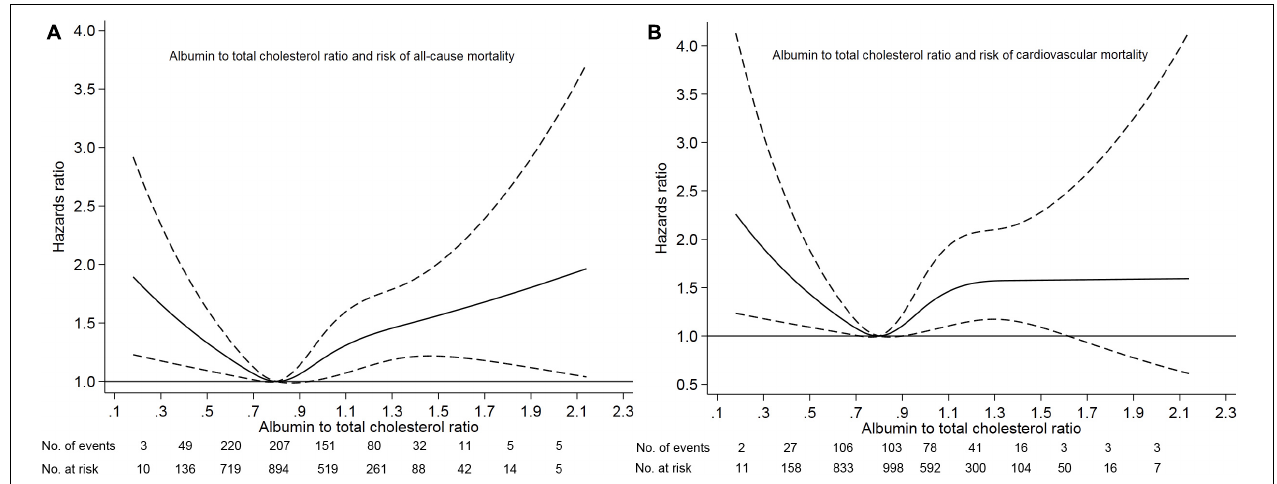
FIGURE 1 | Association of albumin to total cholesterol ratio with risk of mortality. Panel (A) showed a restricted-cubic-spline plot of the association between albumin to total cholesterol ratio and all-cause mortality. Panel (B) showed a restricted cubic-spline plot of the association of albumin to total cholesterol ratio and cardiovascular mortality. All plots were adjusted for age, sex, body mass index, systolic blood pressure, current smoking, alcohol intake, comorbid conditions, medication use, laboratory measurements. Dashed lines indicate 95% confidence intervals. The median albumin to total cholesterol ratio (0.80) was the reference standard, indicated by the gray